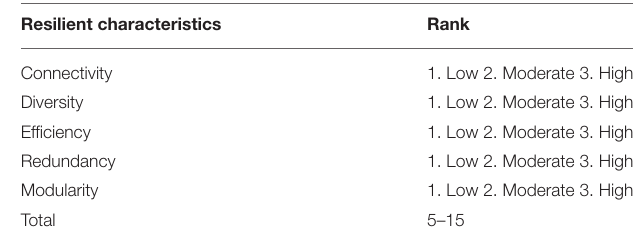
TABLE 5 | Contextualizing the measurements of resilient urban form in refugee neighborhoods.